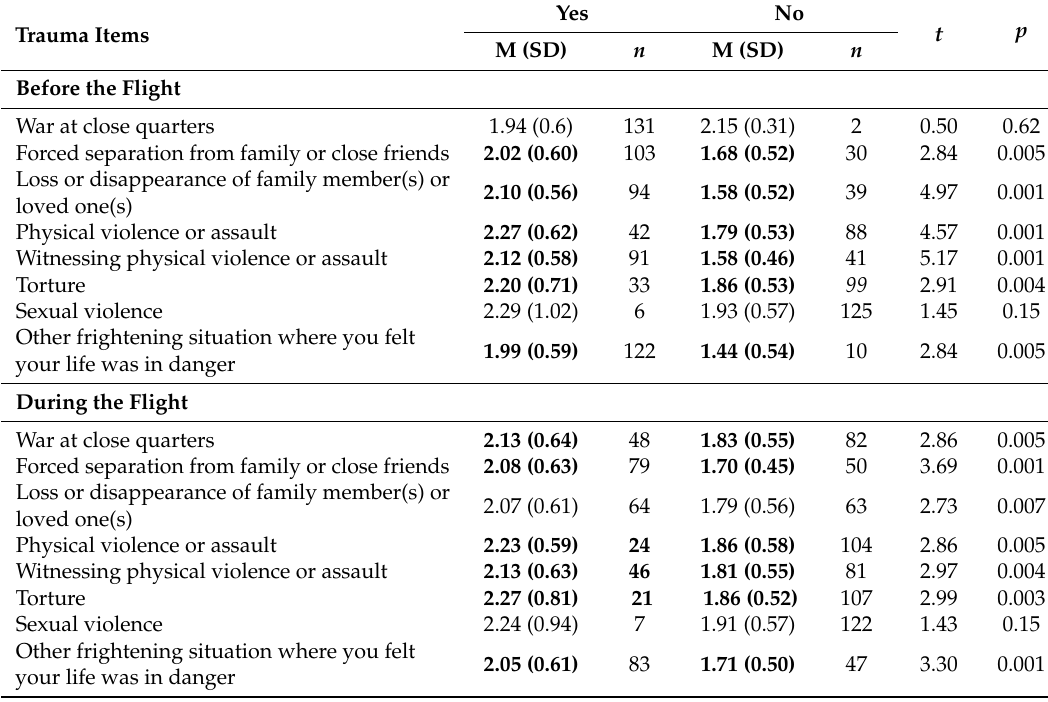
Table 3. Means, standard deviation, and independent t -test of the differences in regard to PTSD symptom scores for endorsers and non-endorses of RTHC